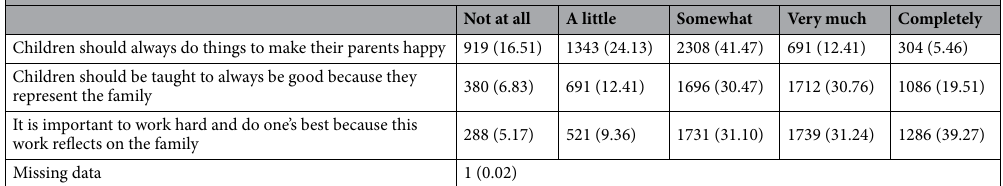
Table 4. Distribution of caregiver responses to questions on beliefs related to children’s behavior towards the family (unrelated to religion), using the Mexican American Cultural Values Scale (MACVS). Percentages are out of all n = 5566 participants.